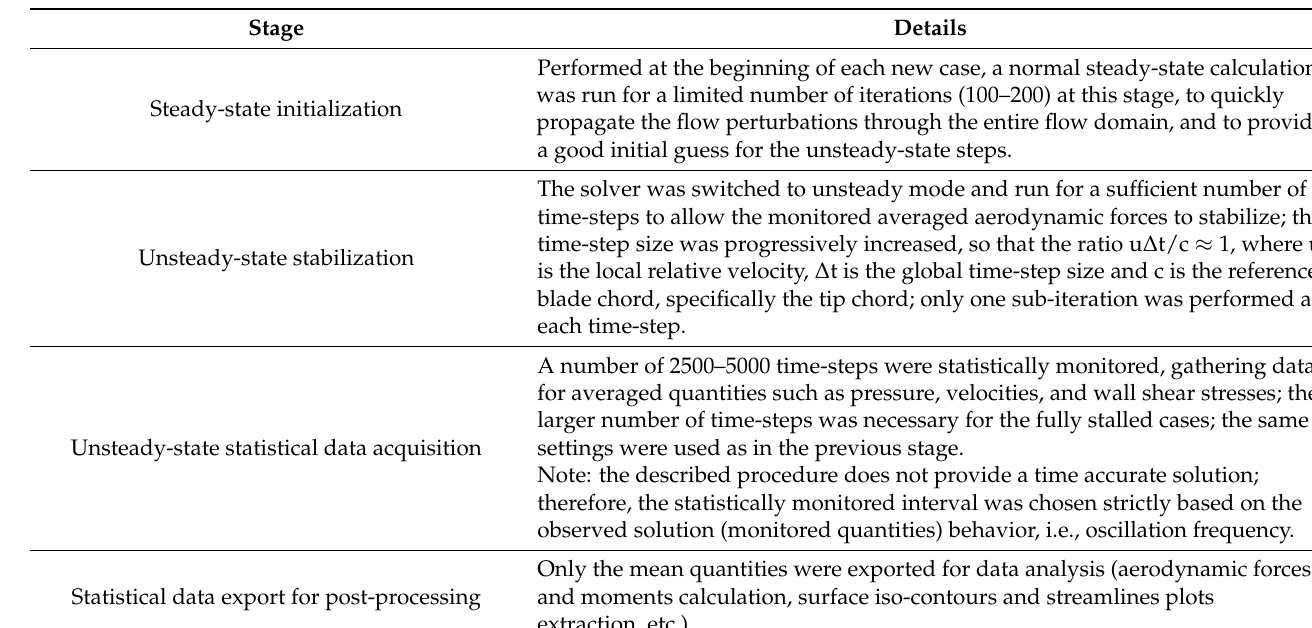
Table 3. Method used to obtain statistically steady results in stalled